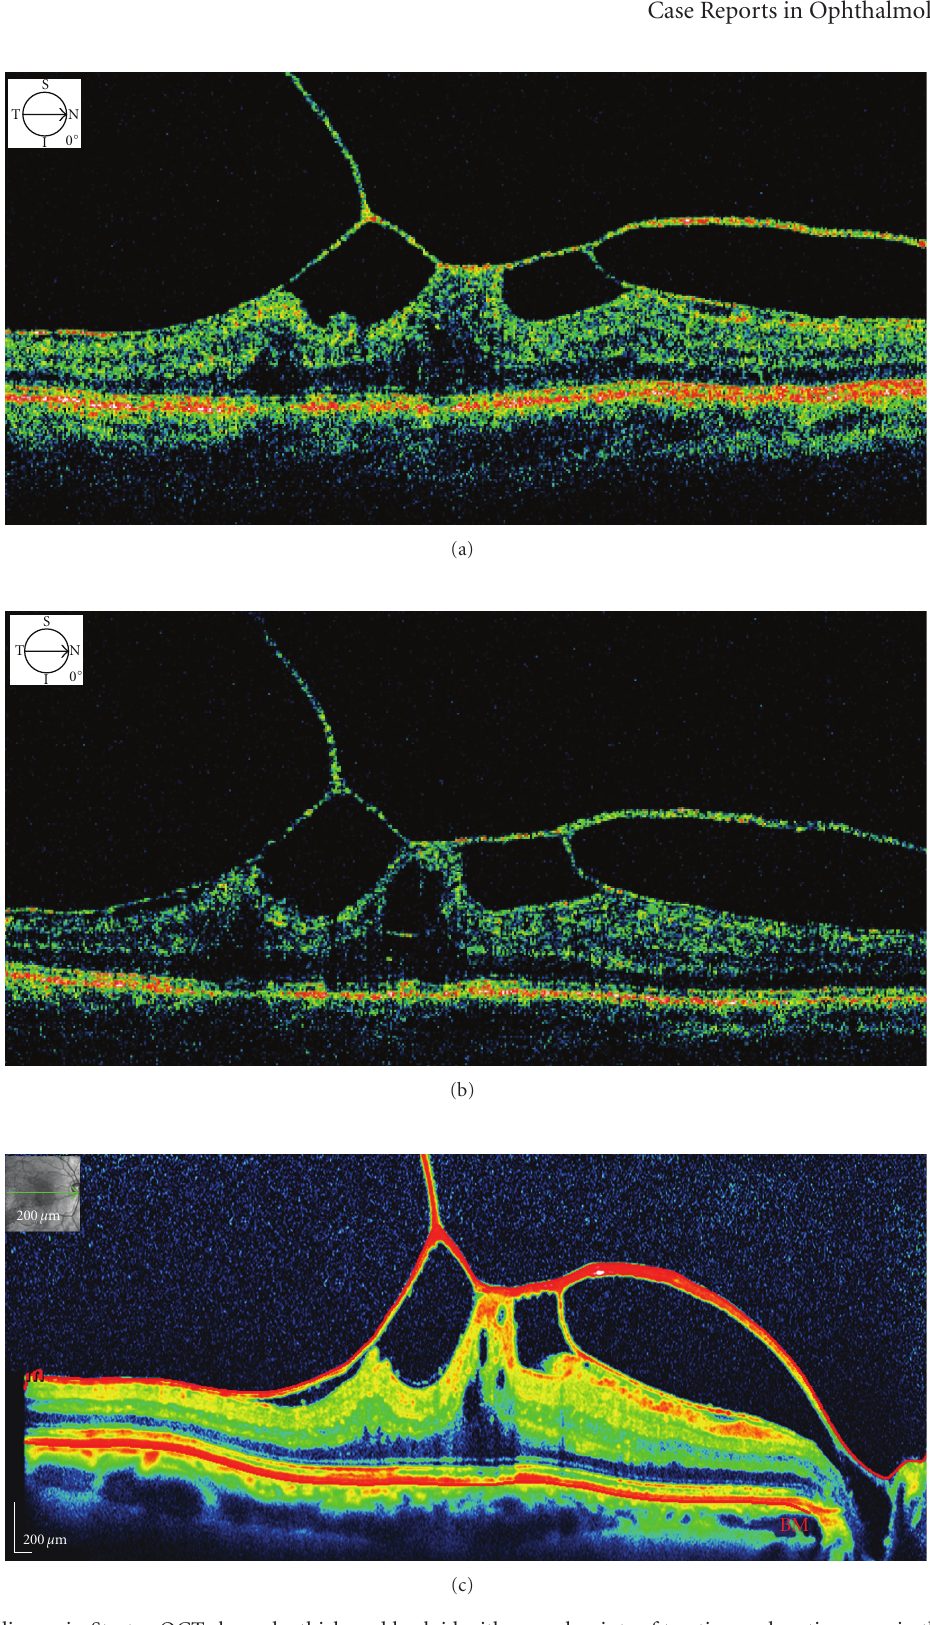
Figure 1: (a) At diagnosis, Stratus OCT showed a thickened hyaloid with several points of traction and cystic spaces in the internal retinal layer. Top left corner shows the direction of the scan. (b) Five years after diagnosis, Stratus OCT demonstrated unchanged features. Top left corner shows the direction of the scan. (c) Ten years after diagnosis, Spectralis OCT shows unchanged morphologic features with integrity of outer retina (photoreceptor inner and outer segment junction and external limiting membrane). Top left corner shows the direction of the